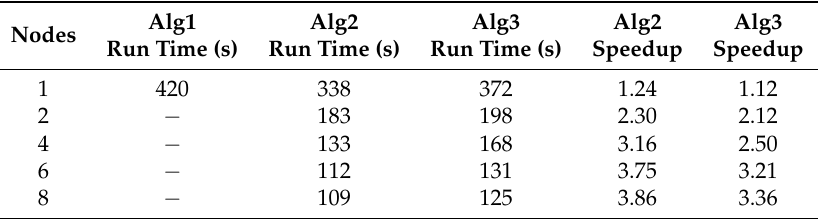
Table 3. Run time and speedup comparison with different algorithms.